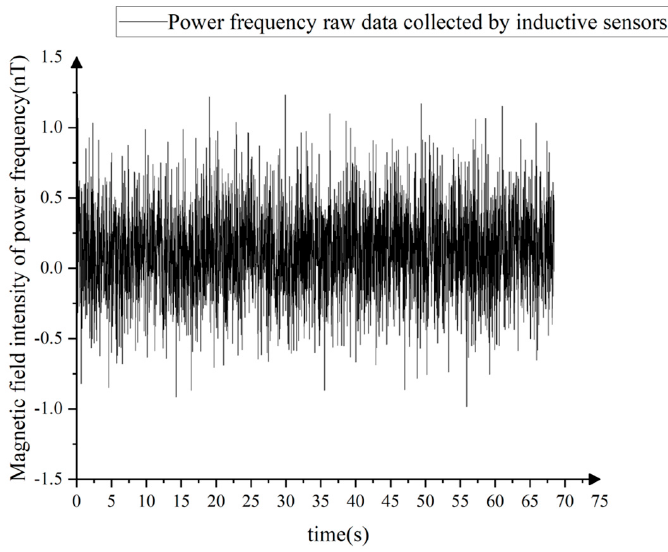
Figure 6. 50 Hz signal with target from 3 − axis inductive sensor.